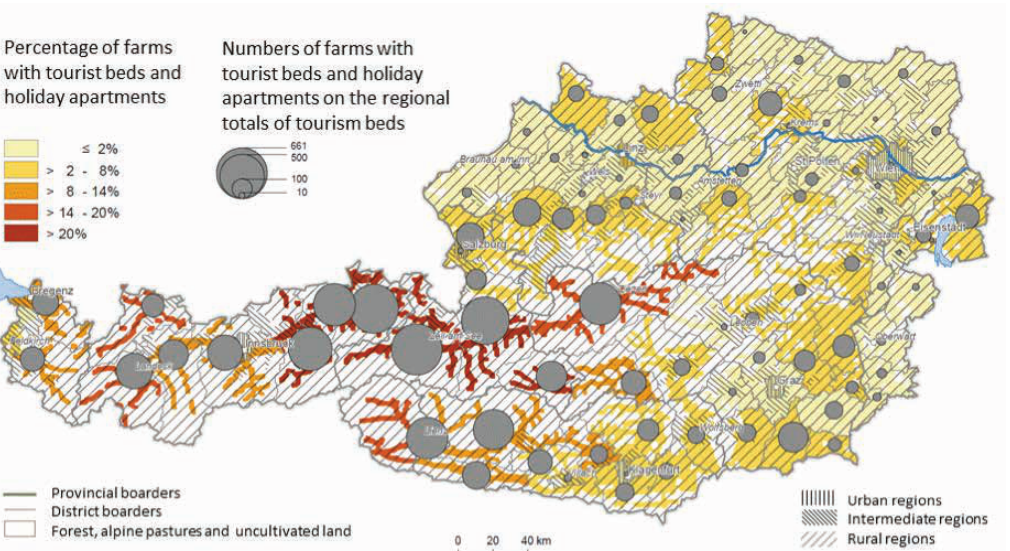
Figure 4: Farm Structure Survey 2010 – number of tourist beds and farms by districts and NUTS3 regions (Statistics Austria 2012: slide 39; Statistics Austria 2013: 124)